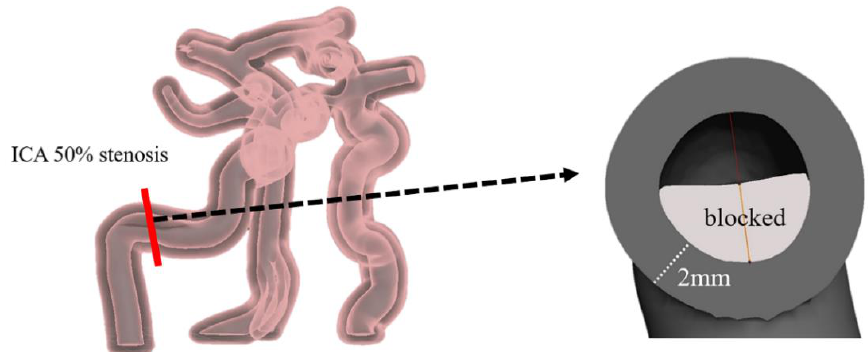
Figure 2. A cross-sectional image of the configuration of the stenosis in the right internal carotid artery (ICA) 50% stenosis model (ICA50). Note that the wall thickness and inner diameter of the vessel are 2 and 4.9 mm, respectively.